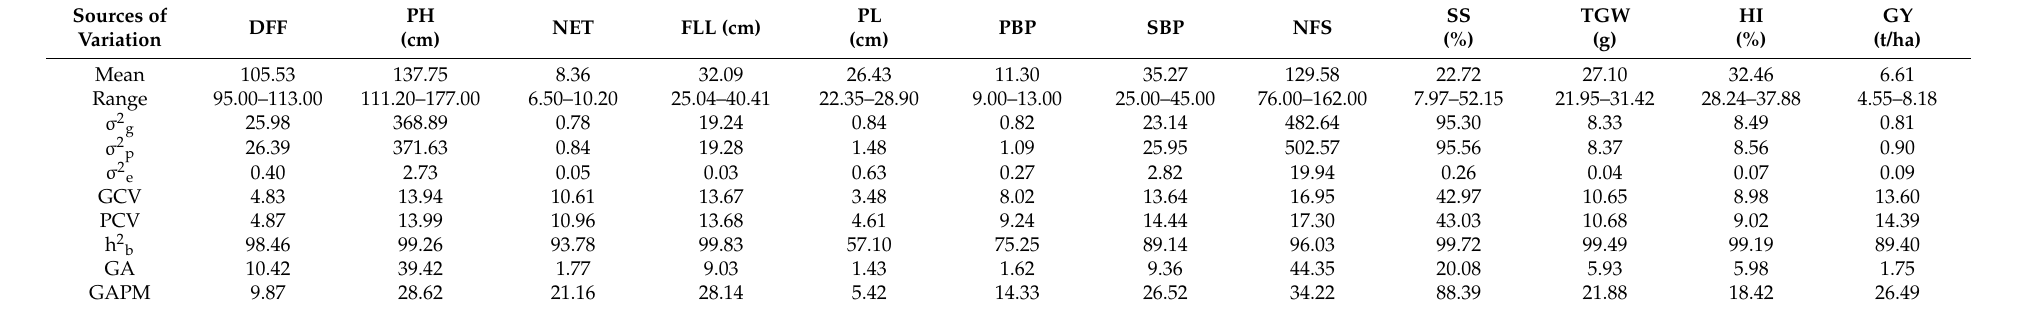
Table 2. Estimation of genetic parameters for yield and its component characters in 20 genotypes of T. Aman